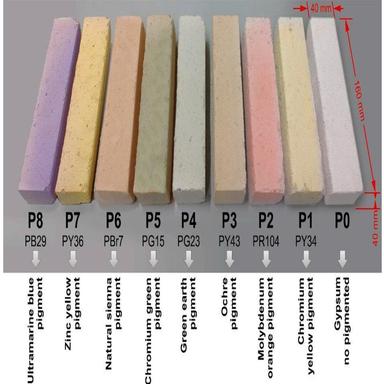
Paste and gypsum samples (Type P), without pigment (P0) and with the different pigments used (P1 to P8) ninety days after their preparation.